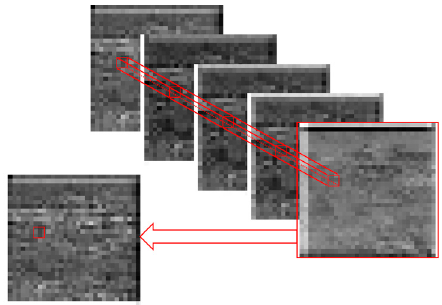
Figure 8. A comparison of the single-frame-based and multiple-frame-based detection. It can be seen that multiple-frame-based detection offers more advantages.